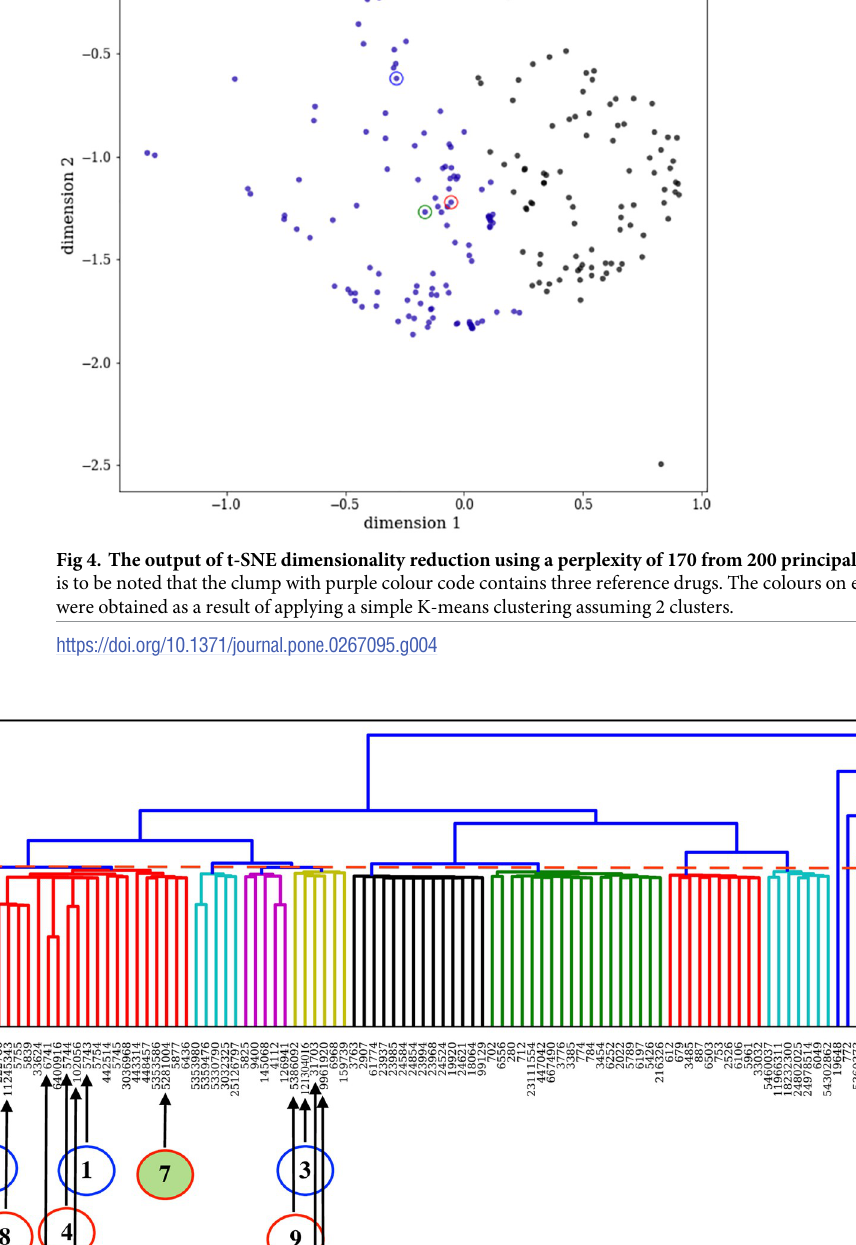
PLOS ONE | https://doi.org/10.1371/journal.pone.0267095 May 24,